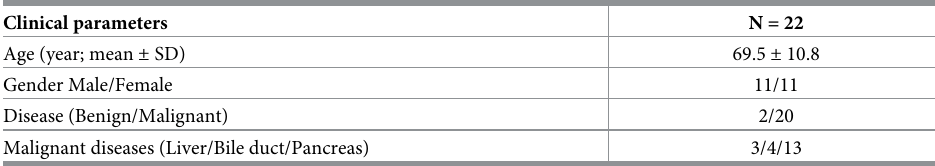
Table 1. Clinical characteristics of samples. Clinical